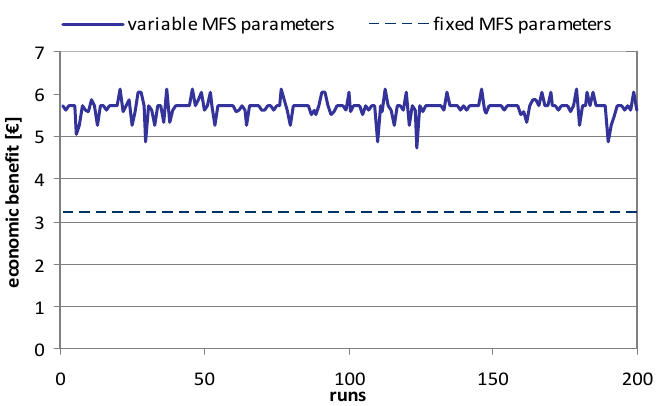
Figure 21. Comparison of the economic benefit after two weeks obtained in 200 runs for fixed and self-adapting sets of MFs parameters—stable scenario.